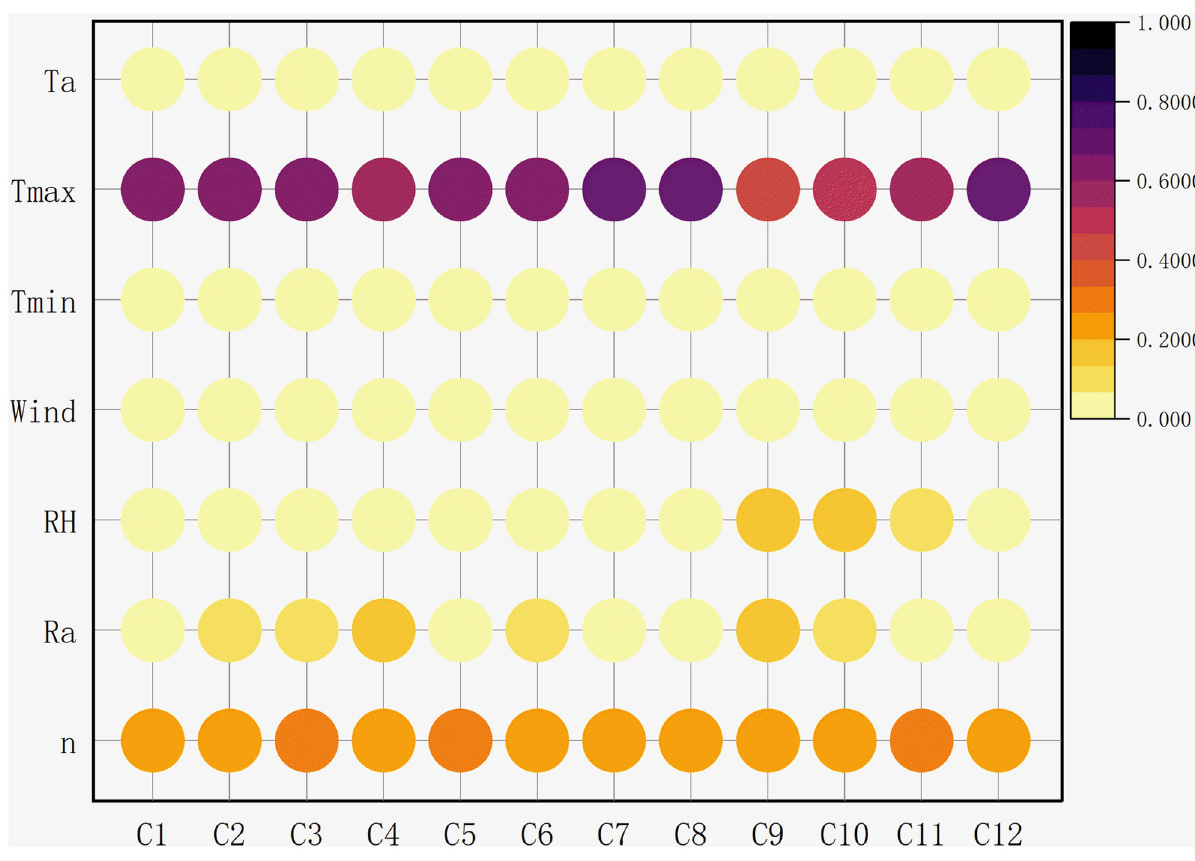
Fig 3. Importance of meteorological factors to ET O at different